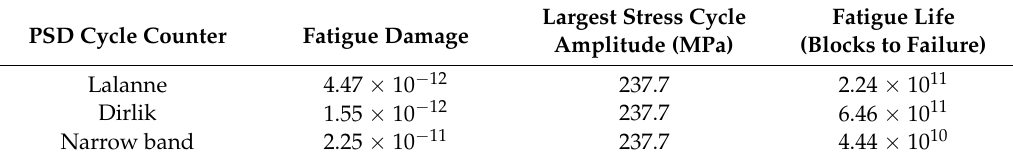
Table 8. Fatigue life using absolute maximum principal stress under residential road excitation.